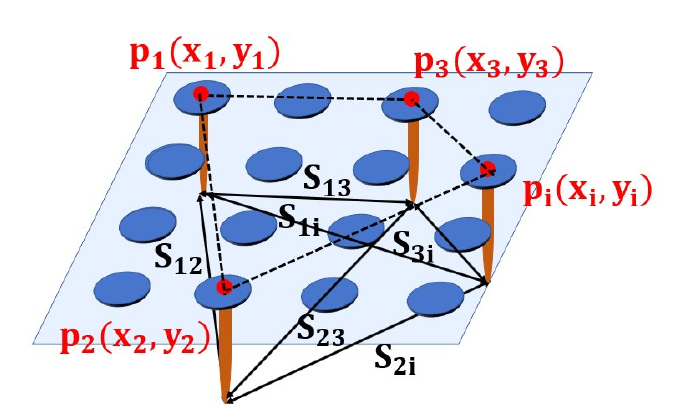
Figure 10. Diagram of the electrodes connected in parallel in a plane.